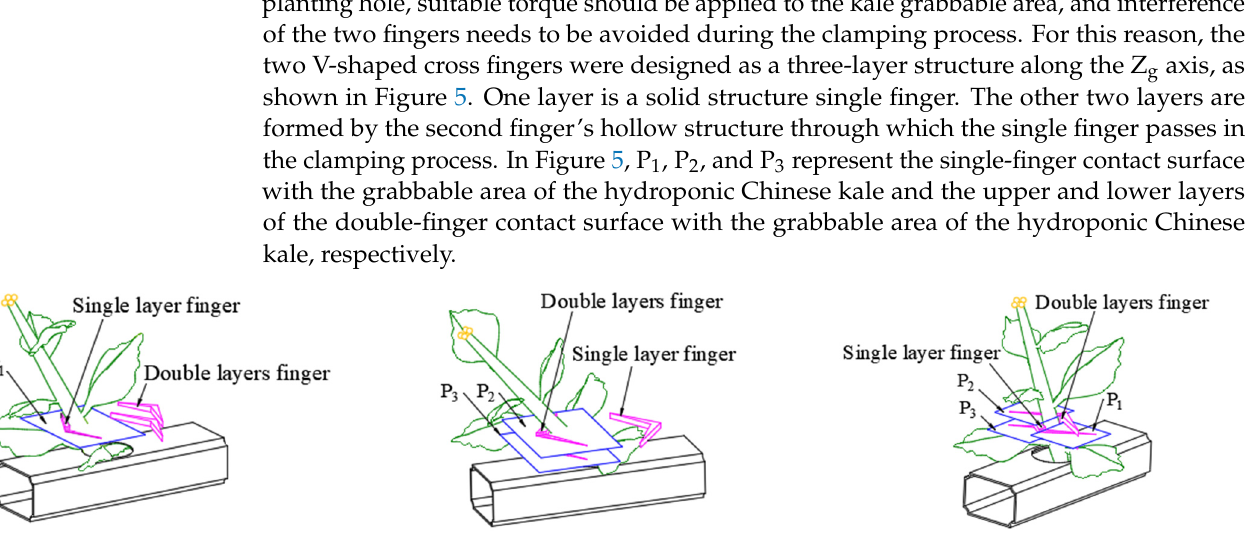
Figure 5. Three-layer contact surfaces of two V-shaped cross fingers: ( a ) illustrates the middle sing- layer finger contact surface, ( b ) illustrates the double-layer finger contact surfaces, and ( c ) is the cross-clamping illustration of the two fingers.